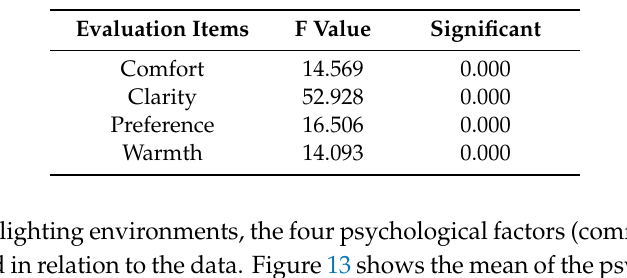
Table 5. Results of one ‐ way ANOVA of different psychological perceptions in three lighting environments.